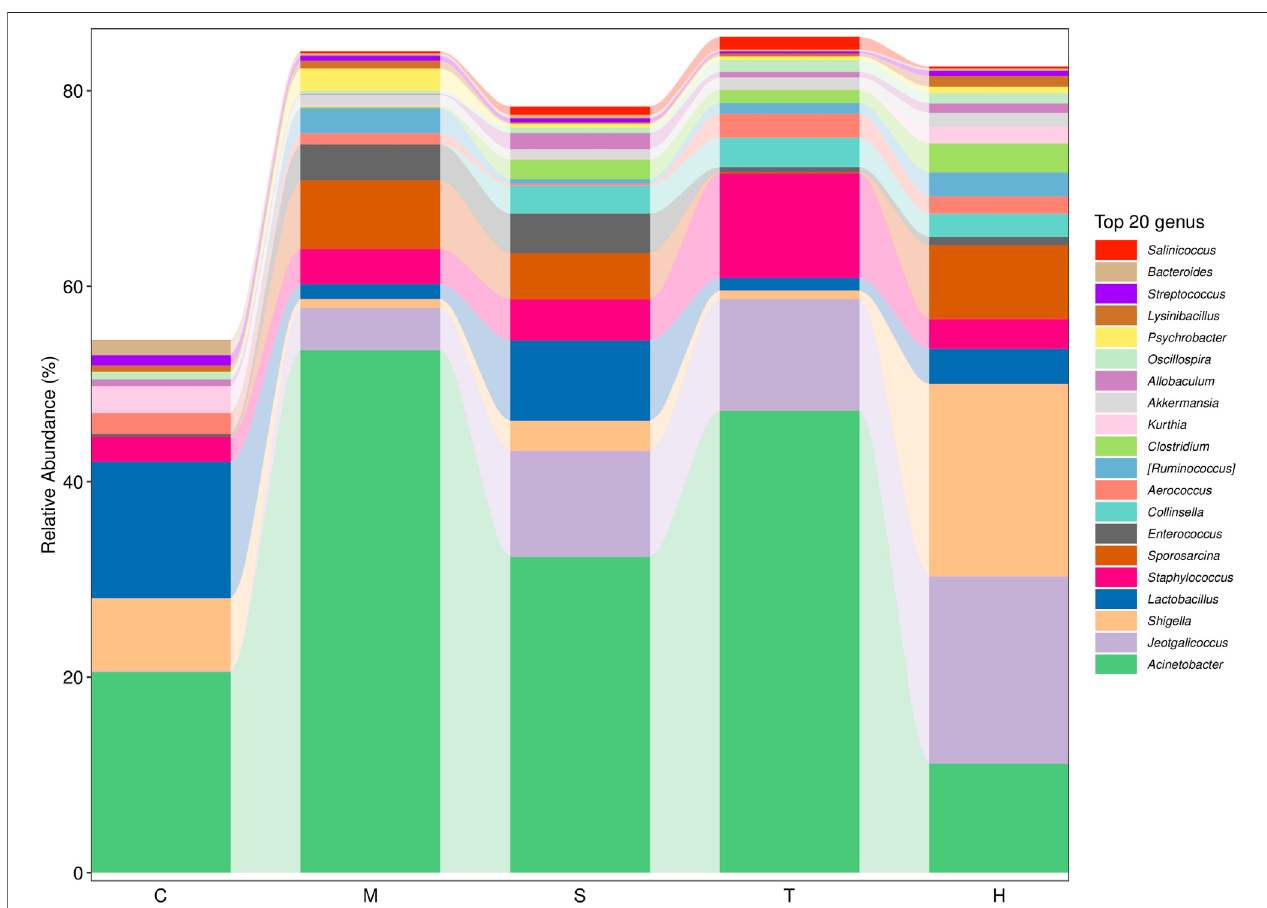
FIGURE 5 | Histogram of mean value of intestinal micro fl ora enrichmentin mice at the genus level in each group. C: control; M: model; S: salidroside; T: tyrosol; H: hydroxytyrosol.